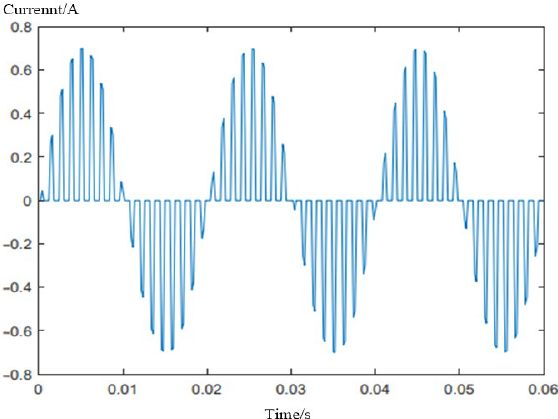
Figure 3. Topological identification of current characteristics.